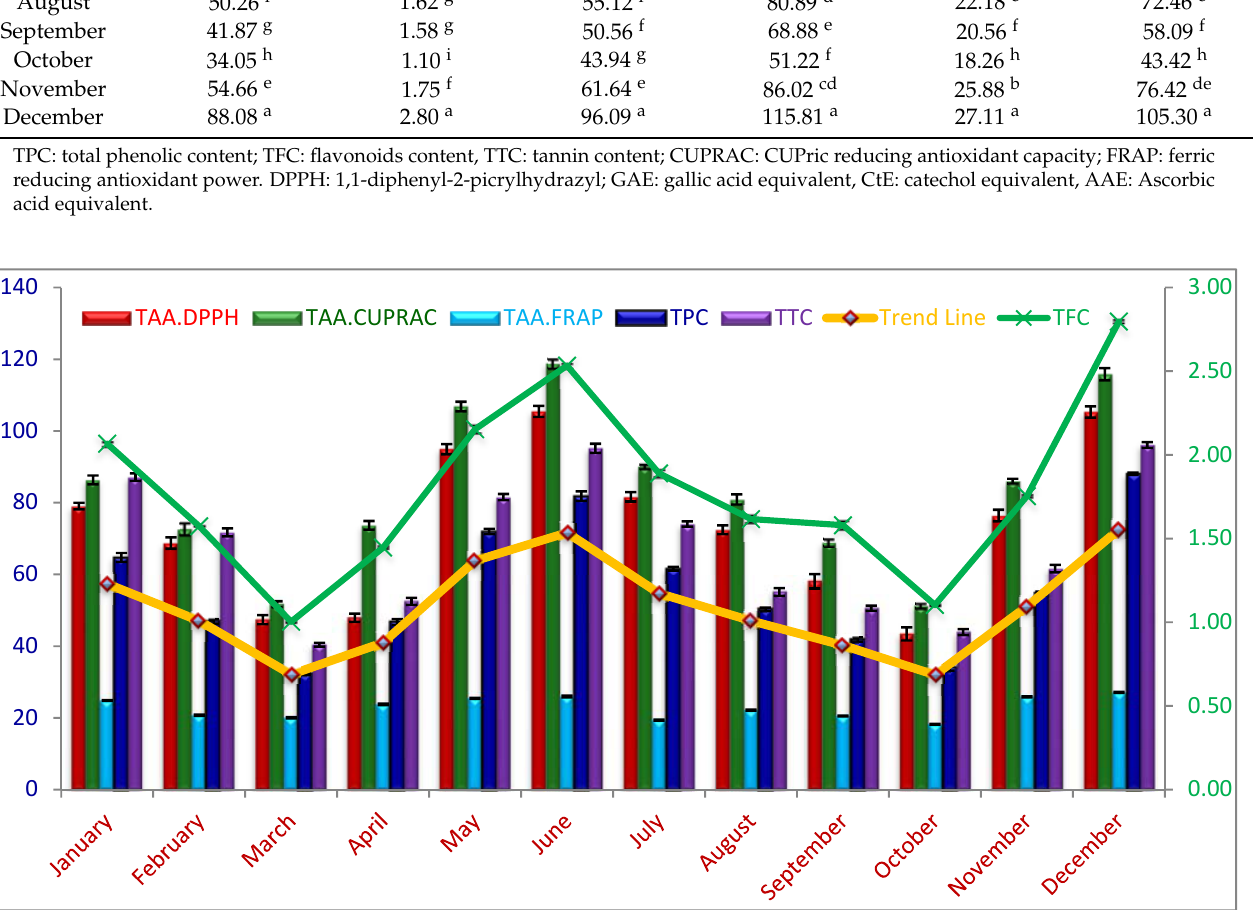
Figure 2. Changes in total phenolics, flavonoids, tannin, and total antioxidant activity of Calligonum polygonoides L. Foliage during different seasons under extreme climatic condition. Data are presented as mean ± SD, n = 3 experiments, p < 0.05.